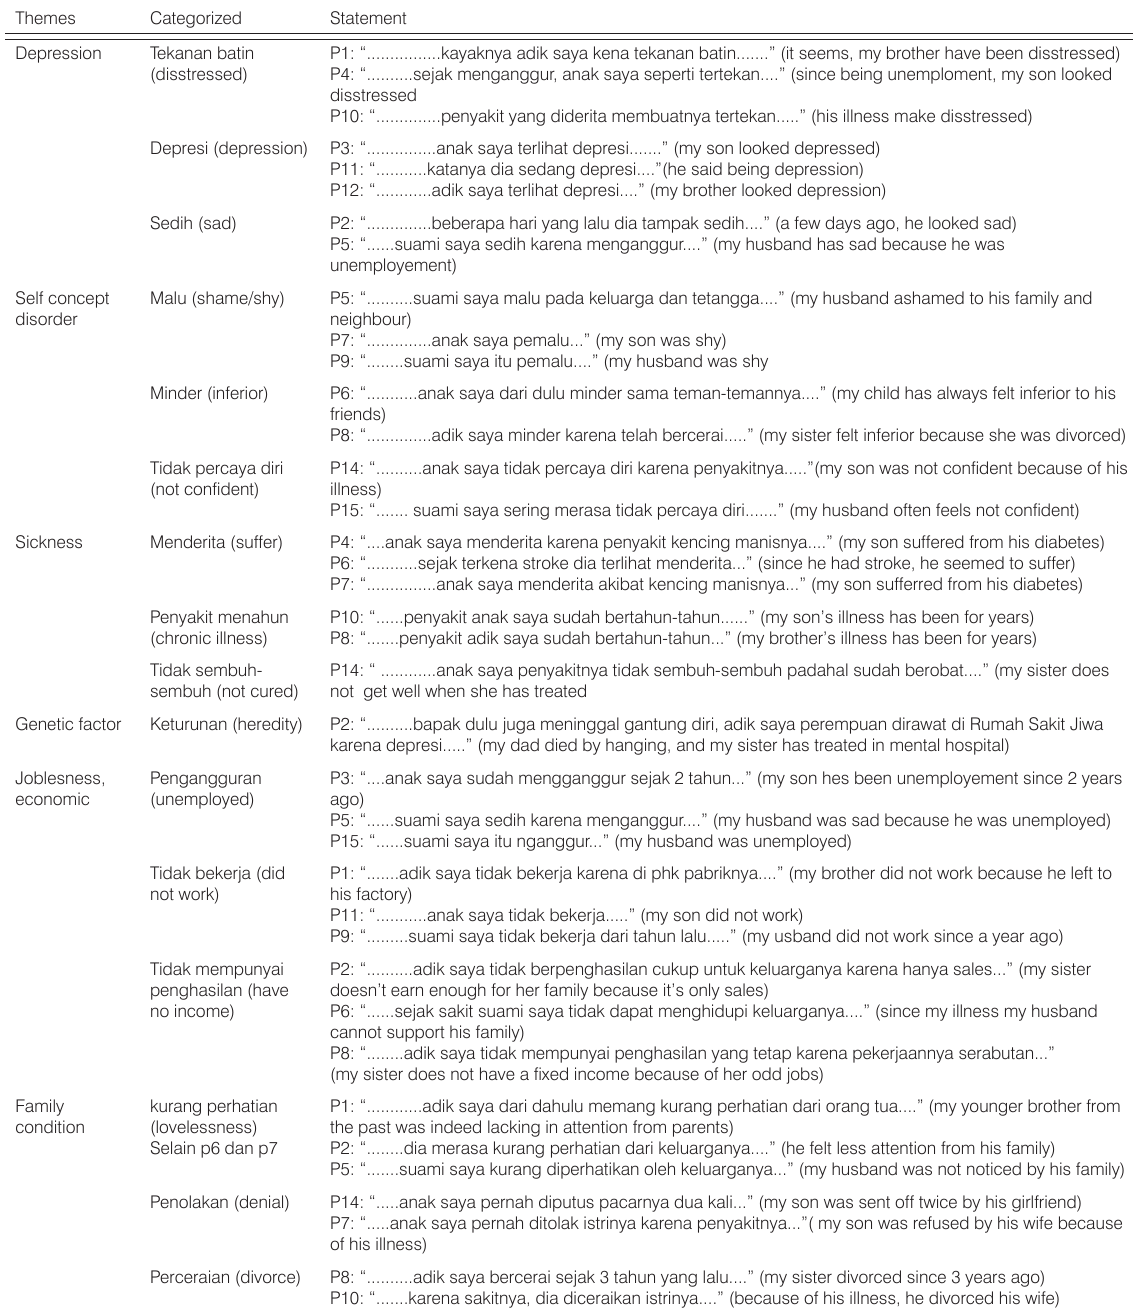
Table 3. Theme indentified based on the experiences of family members with suicide history.